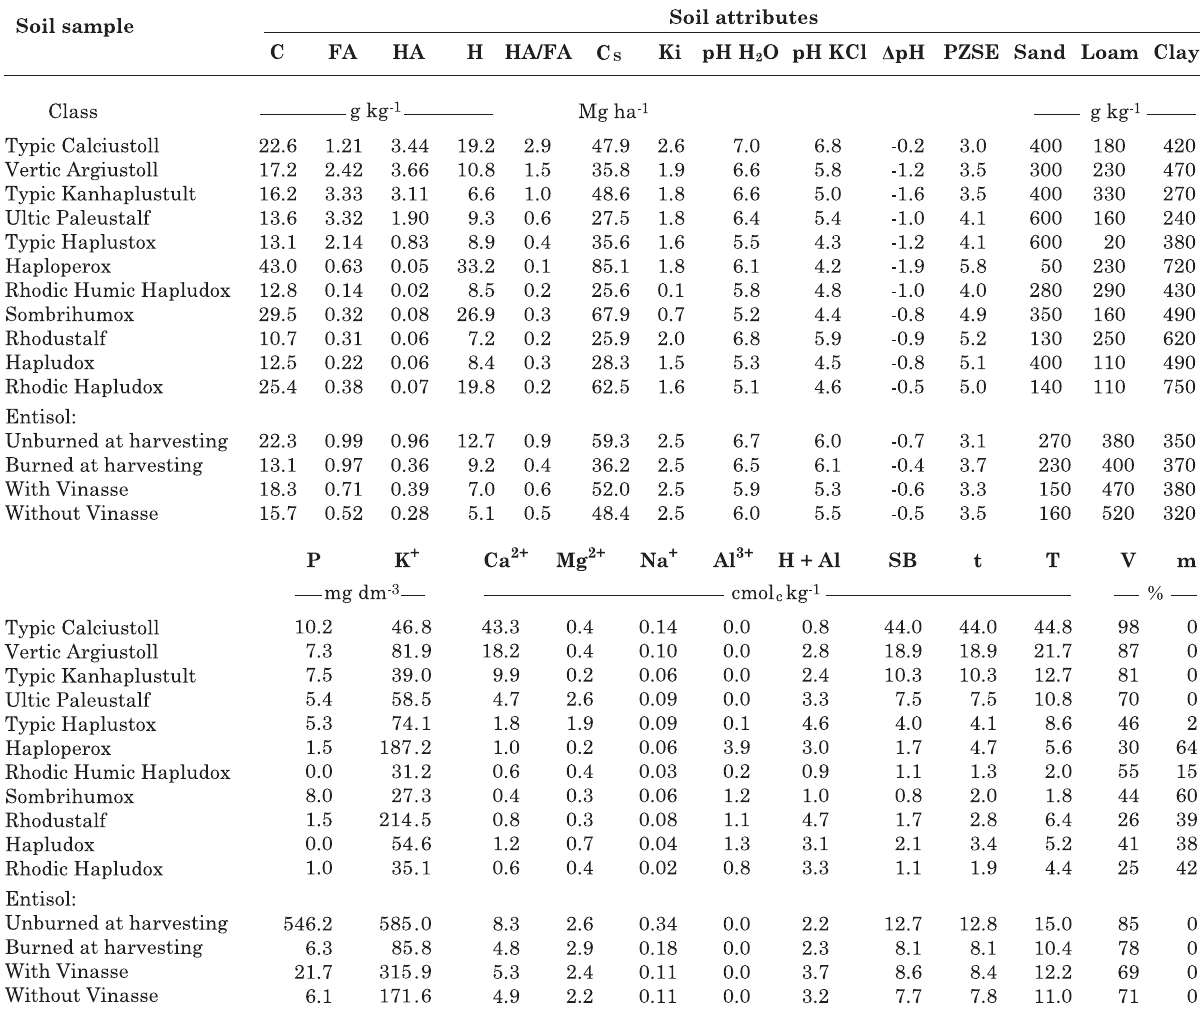
Properties: C, FA, HA e H: total carbon, fulvic acids, humic acids and humins, respectively; C